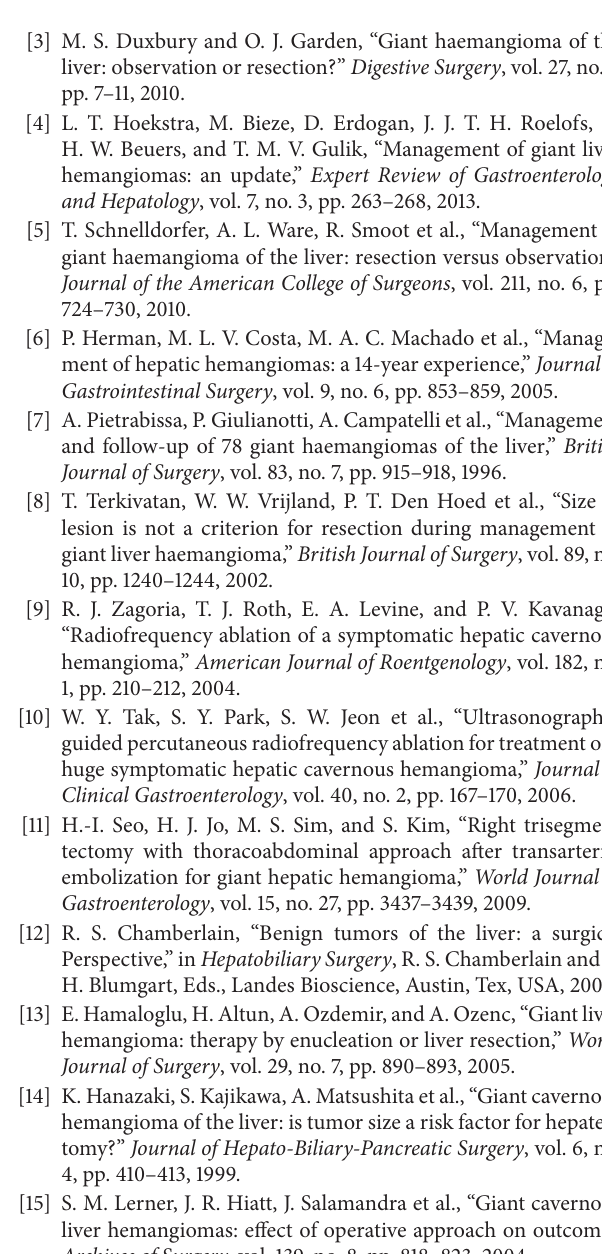
Figure 3: Large vascular channels separated by fibrous strands lined by single layer of flattened epithelial cells with normal mitotic activity.